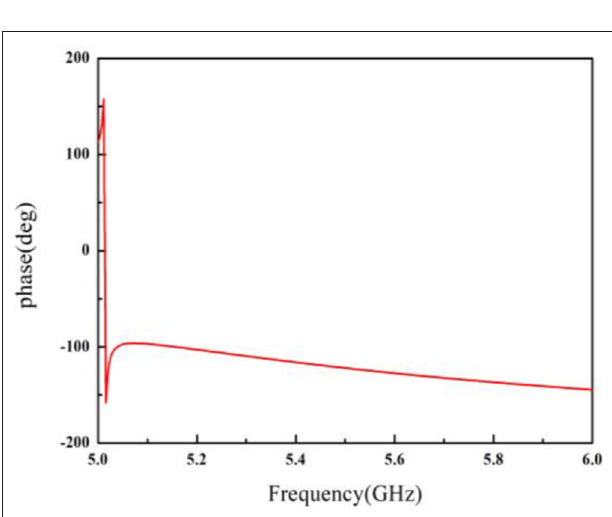
FIGURE 6 | Reflection phase at superstrate for x-polarized incident